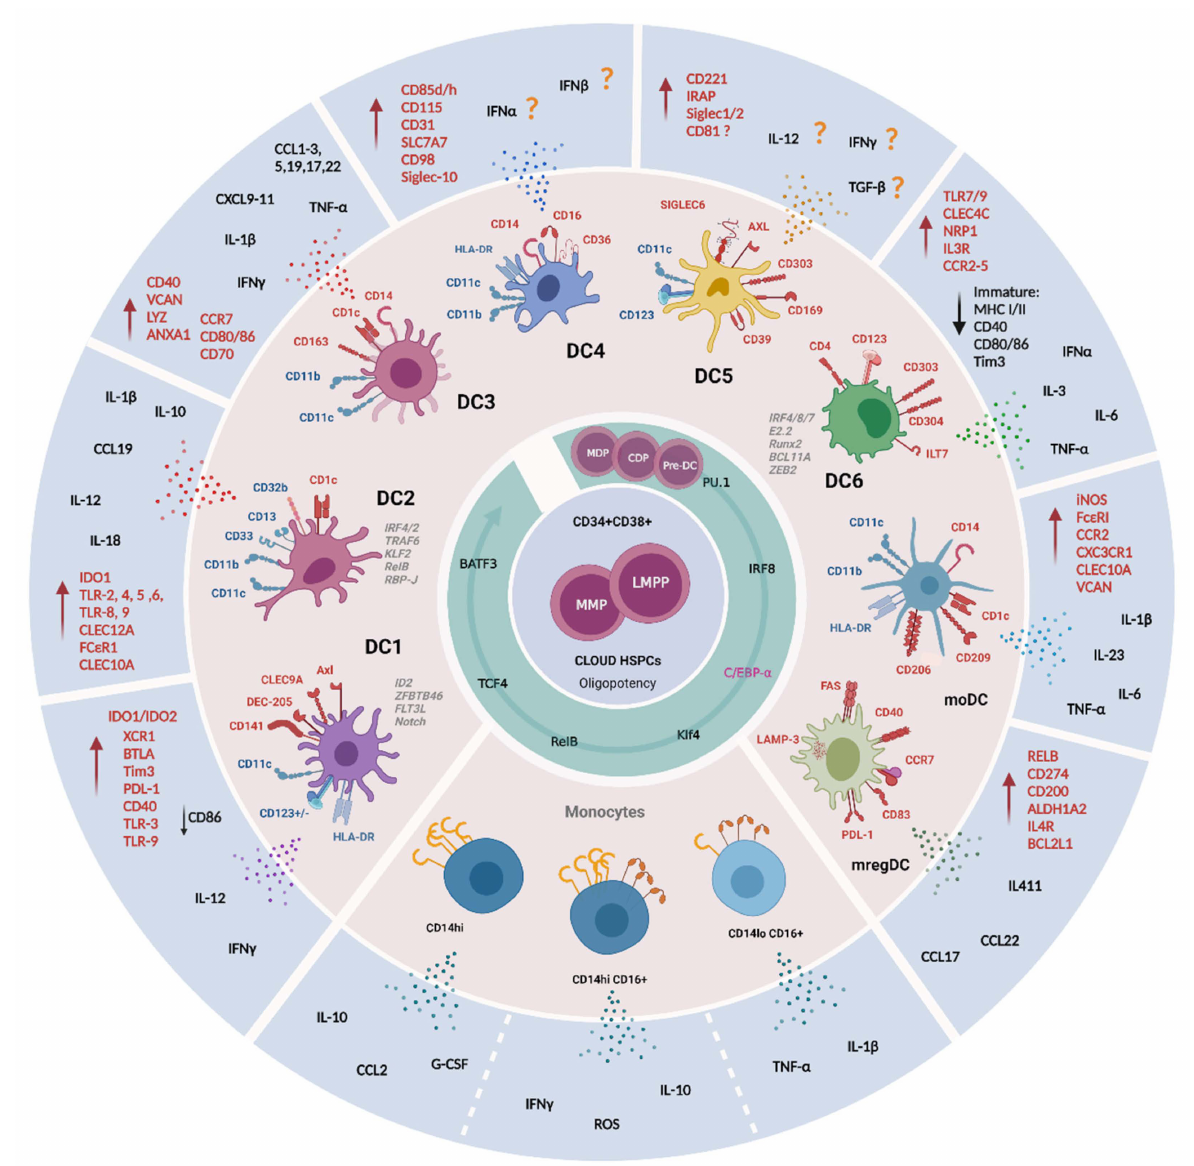
Figure 1. Overview of DC and monocyte subsets. The inner circle shows key differentiation associated TFs and proteins. The second circle shows the subsets with canonical TFs, surface and intracellular markers, the red color markers are the key molecules to distinguish the subpopulation, the blue color shared markers between populations, main transcription factors for some subpopulations are described in gray. The outer circle illustrates secreted proteins, surface receptors and key protein changes upon activation, red arrows indicate upregulation of the molecules, the black arrow down regulation. The molecules with question marks are proposed based on the genomic profile found in the